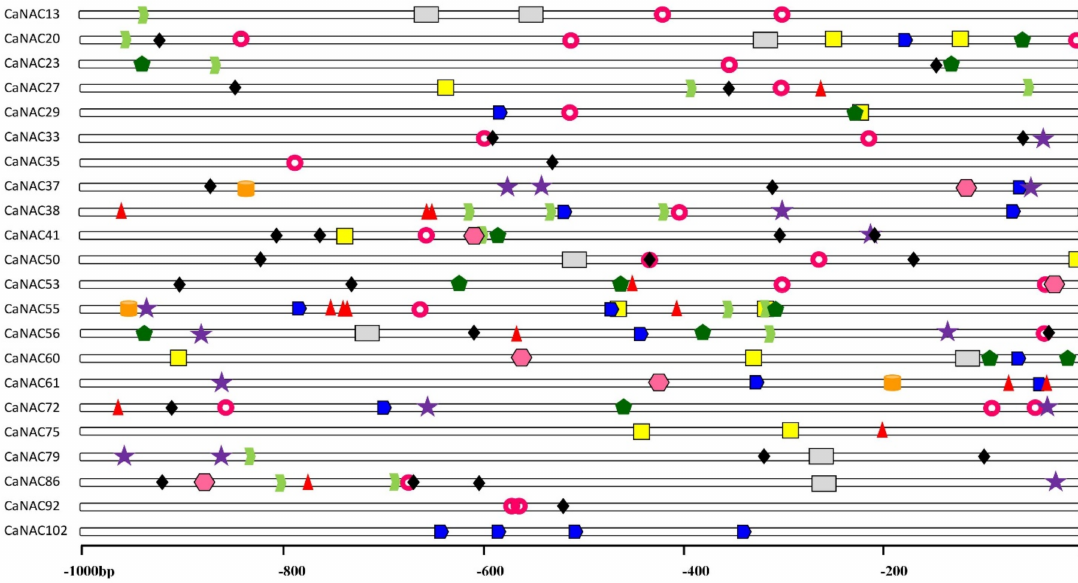
Figure 6. Predicted cis -elements in the promoter regions of CaNAC genes. The promoter sequences ( − 1000 bp) of 22 CaNAC genes were analyzed. The names of the CaNAC genes are shown on the left side of the figure. The number at the bottom indicates the number of the nucleotides to the translation initiation codon, ATG. The elements are identified as follows: green dovetail for the CGTCA element, red triangle for the ABRE element, yellow square for the W-box element, purple five-pointed star for the TCA element, black diamond for the TC-rich repeats element, dark green pentagon for the MBS element, orange oval for the WUN element, blue pentagon for the GARE element, pink circular crown for the HSEs element, the grey rectangle for the ERE element, the rose red hexagon for the LTR